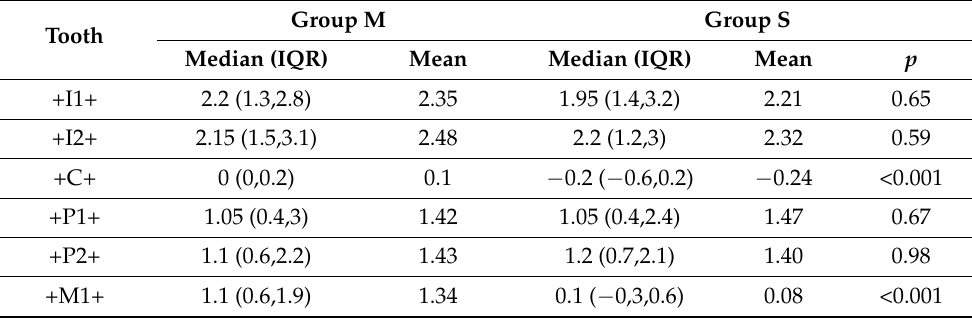
Table 5. Statistical analysis of the intergroup PTV differences in examination